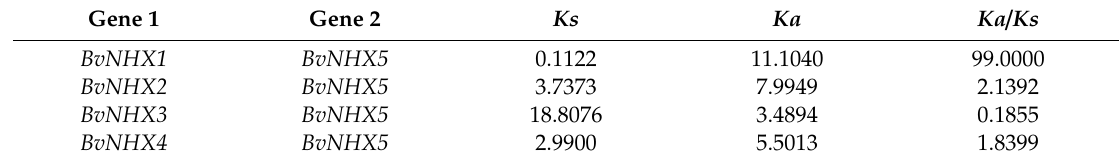
Table 4. Ks and Ka substitution rates in BvNHX paralog genes.